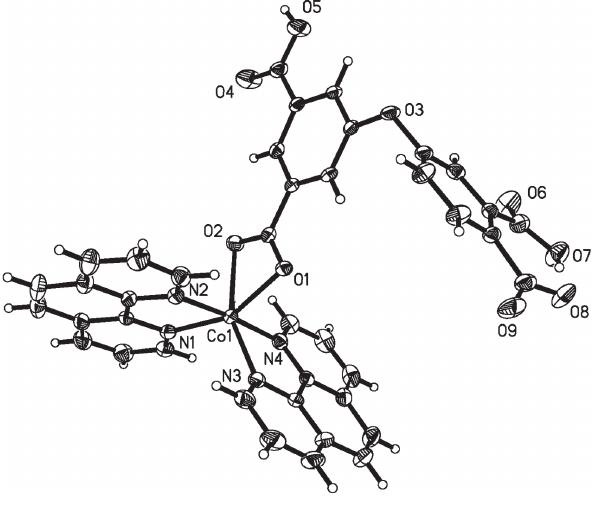
Table 1 contains crystallographic data and Table 2 contains the list of the atoms including atomic coordinates and dis- placement parameters.